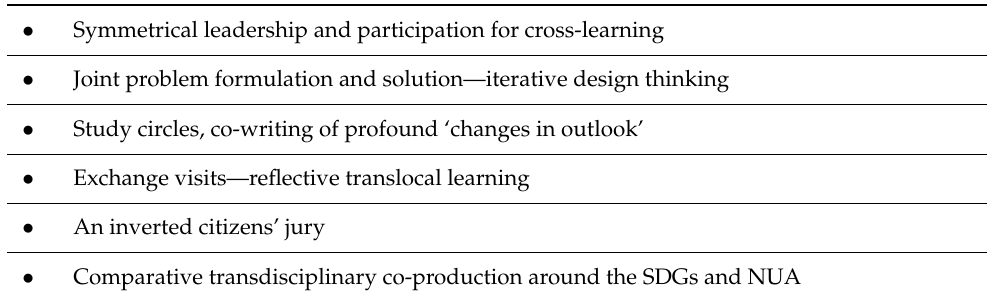
Table 1. Selection of co-production methods utilised by Mistra Urban